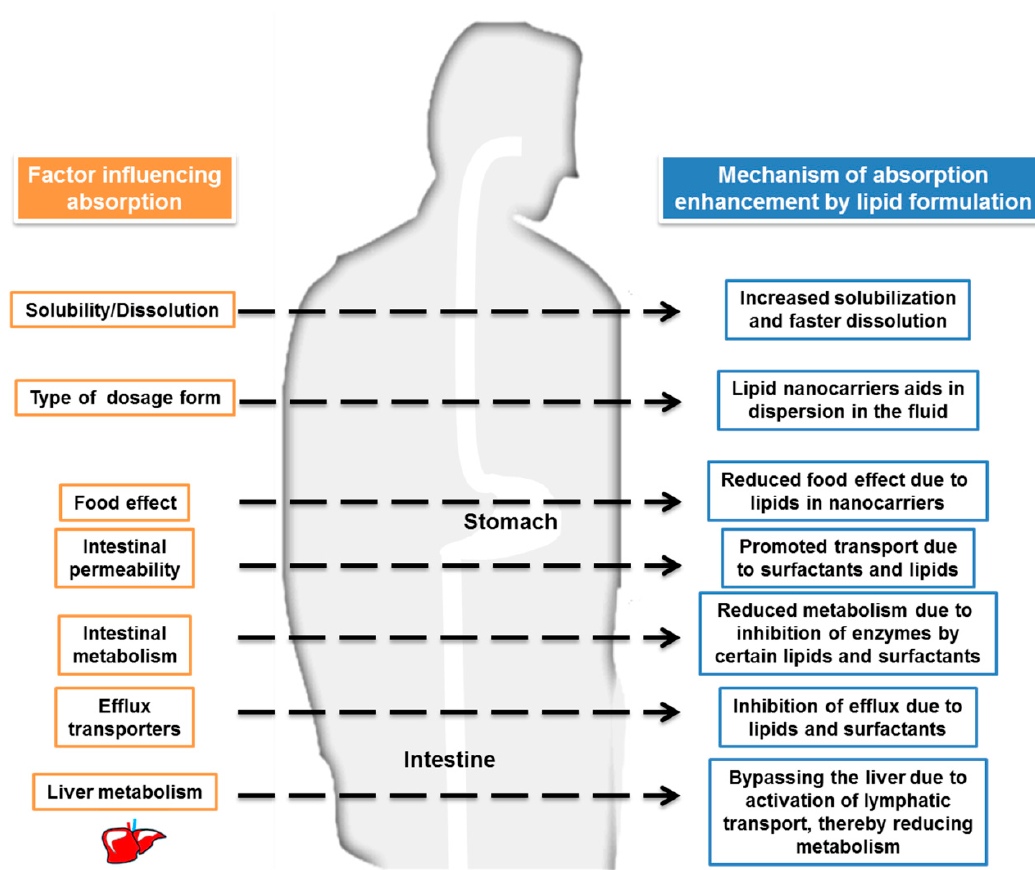
Figure 2. Possible mechanisms for enhancement of vitamin bioavailability using lipid-based delivery systems.